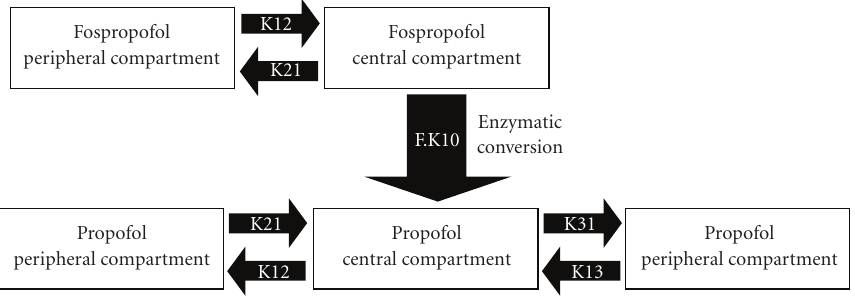
Figure 2: The five-compartment model of fospropofol liberating propofol [67].